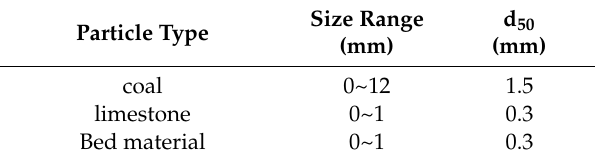
Table 7. Load dynamic simulation conditions of the CFB boiler.